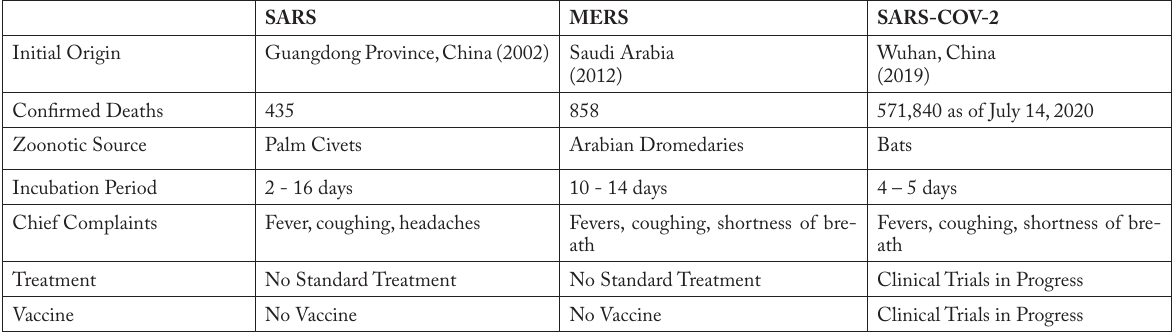
Table 1. A comparison of the SARS, MERS, and SARS-COV-2